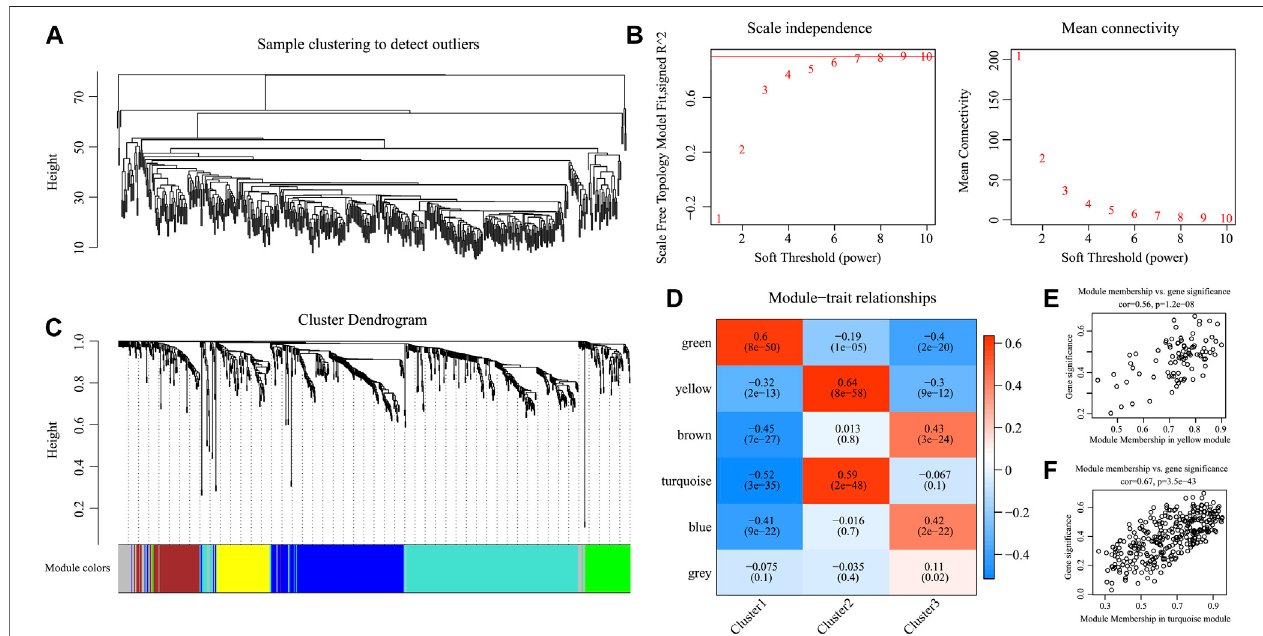
FIGURE7| Weightedgeneco-expressionnetworkanalysis(WGCNA)ofdifferentiallyexpressedimmune-relatedgenesinthethreeHNSCCsubtypesintheTCGA cohort. (A, B) Analysis of network topology for various soft thresholding powers. (C) Hierarchical cluster tree displaying seven modules of co-expressed genes. (D) Heatmap showing the correlation between feature vectors of six modules and three HNSCC subtypes. (E,F) Gene signi fi cance ( y -axis) vs. module membership ( x -axis) plotted for yellow module (E) and turquoise module (F) in the TCGA